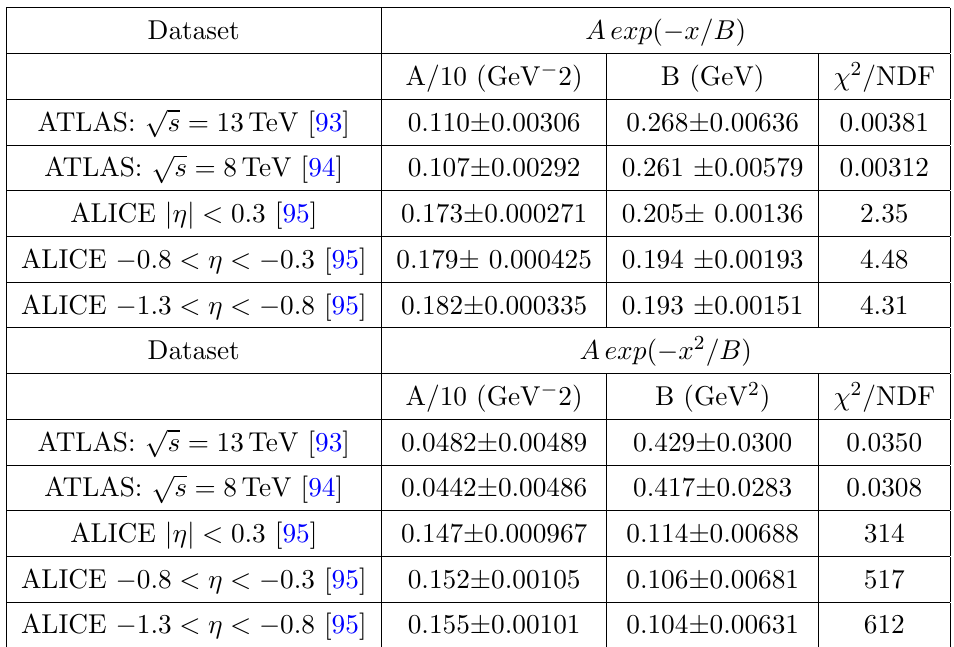
Table 12. Fits of eq. (E.4) and eq. (E.5) to small p colors correspond to the color scheme used in e.g. (cid:12)gure